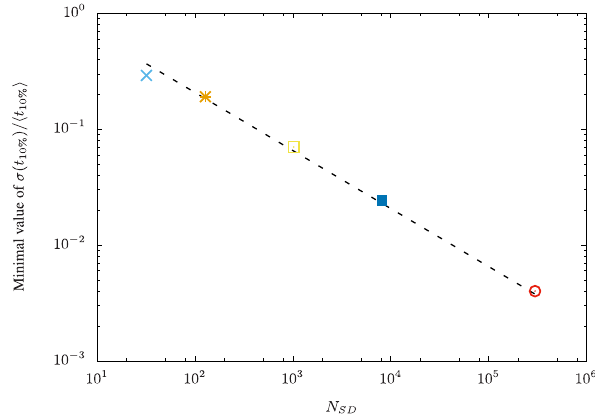
Figure 5. Relative standard deviation of t 10% against cell size. SDM results are based on samples of at least 10 3 realizations. DNS results are taken from Onishi et al. (2015). Where not shown, error bars are smaller than plotted points. The value α = 6 was obtained by curve fitting to the “one-to-one” results. The abbreviation “NLS” in the legend stands for “no linear sampling”.